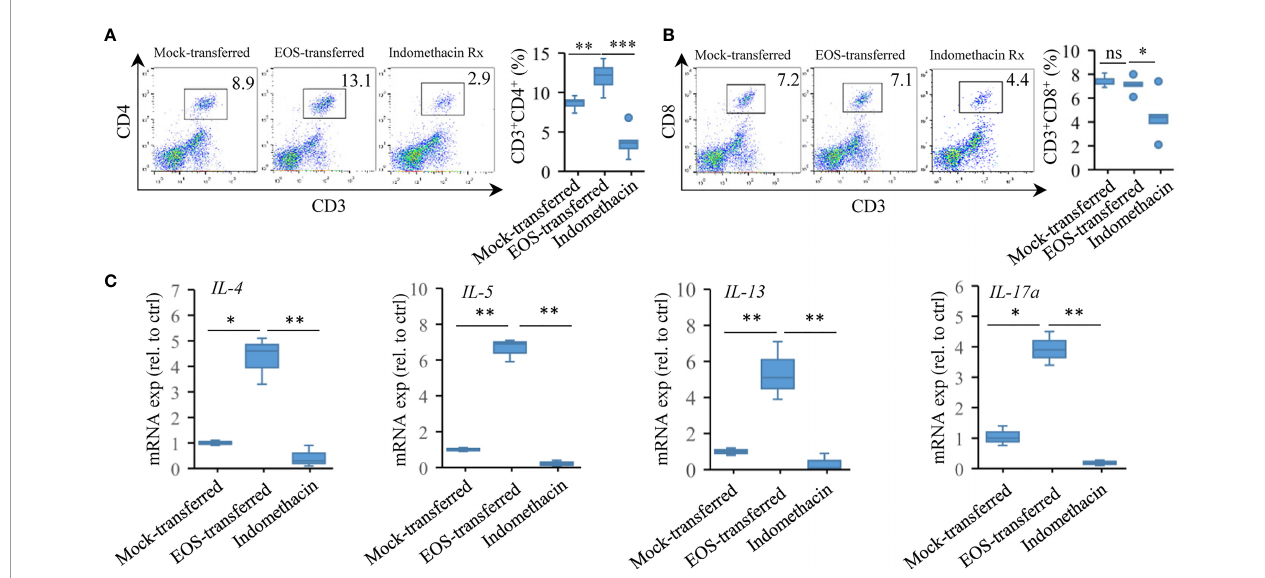
FIGURE 6 | Adoptive transfer of asthmatic eosinophils enhances proin fl ammatory response. (A) CD4 + and (B) CD8 + T-cell accumulation was detected by FACS ( n = 5). (C) Gene expression of IL-4 , IL-5 , IL-13 , and IL-17a in the lung tissues of mock-transferred, EOS-transferred, and indomethacin-treated mice were measured by RT-qPCR ( n = 3). Statistical results are shown: ns, not signi fi cant; * p < 0.05, ** p < 0.01.